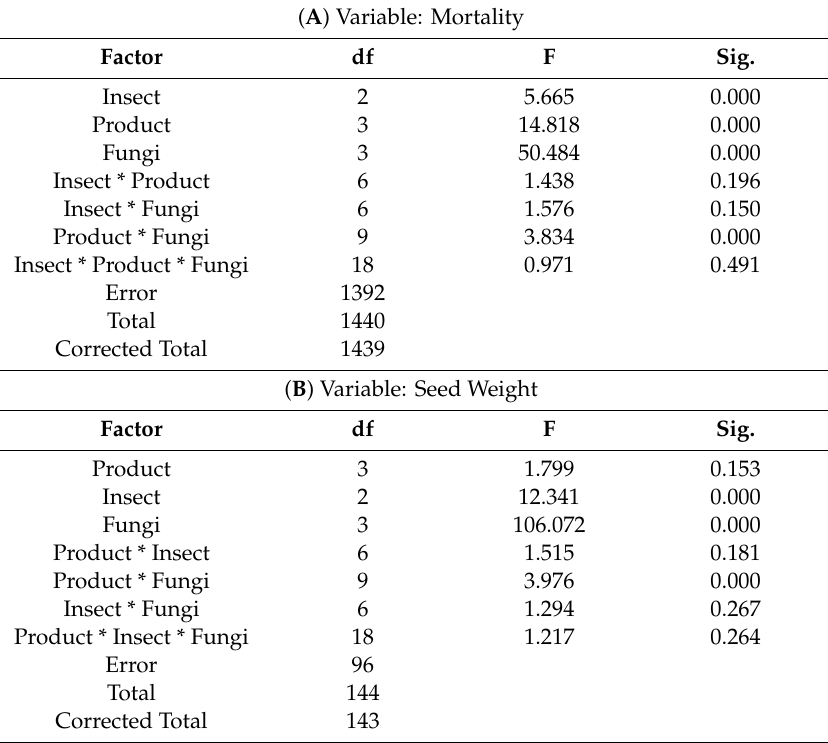
Table 1. Three-way ANOVA post-hoc (Bonferroni test to independent